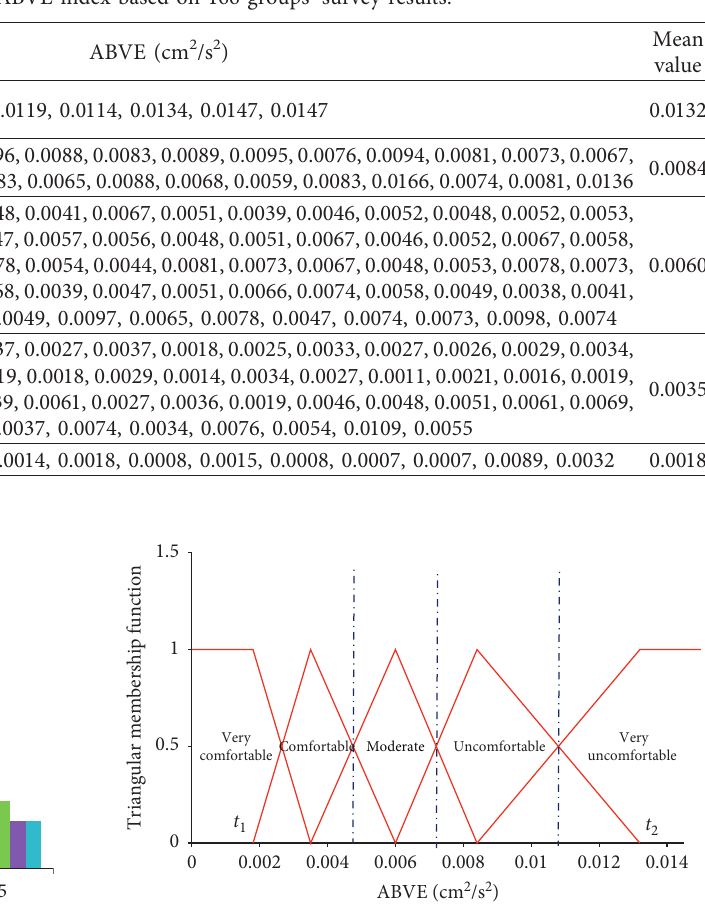
Figure 2: The triangular membership